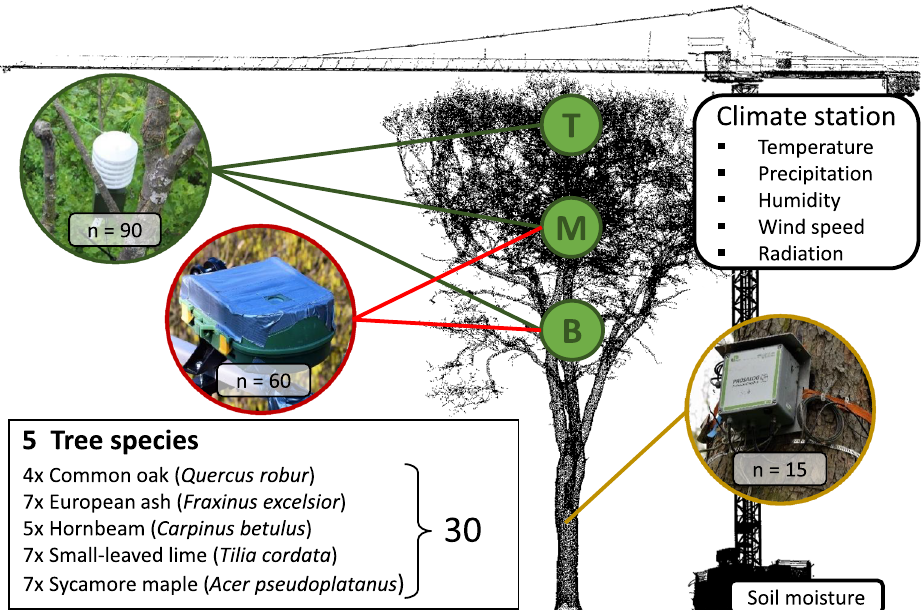
Figure 5. Experimental setup showing measurement locations and number of spatial replicates. Temperature sensors are highlighted in green, phenological cameras in red and the granier sap flow system in